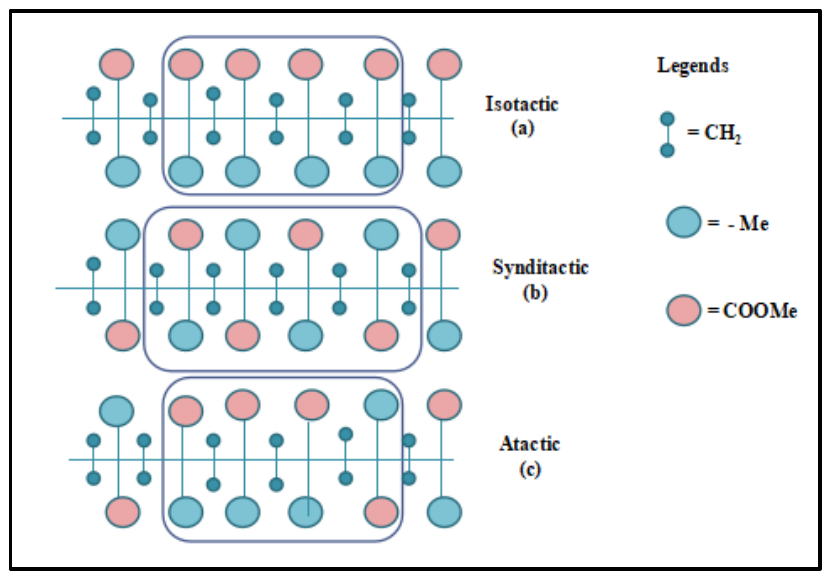
Figure 4. Poly methyl-meth-acrylate (PMMA).